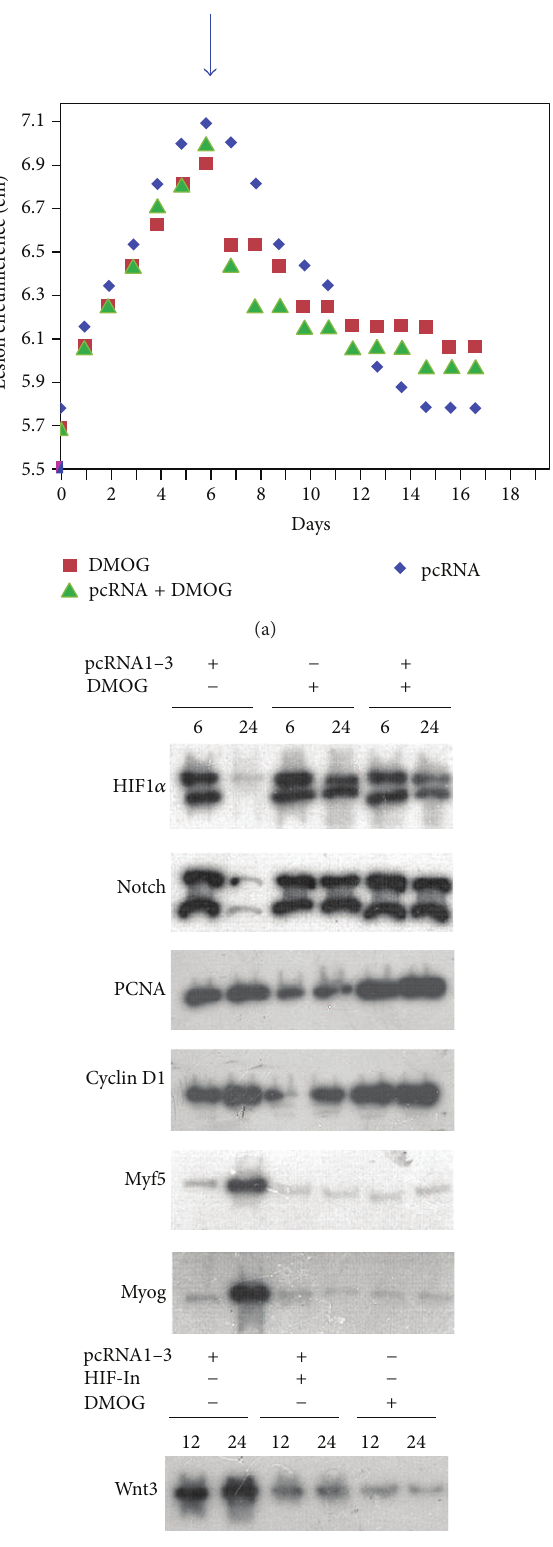
Figure 4: Effect of DMOG on myogenesis. (a) Lesion size of injured muscle treated with DMOG, pcRNA, or a combination of the two. (b) Effect of DMOG, pcRNA, or a combination of the two on expression of the indicated proteins after 6 or 24